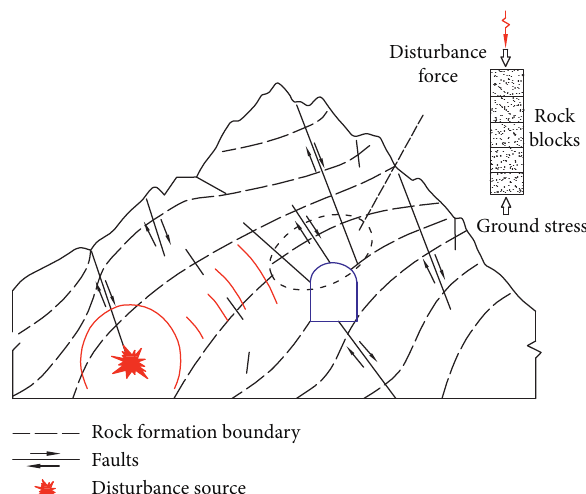
Figure 1: Schematic diagram of disturbance-induced geological